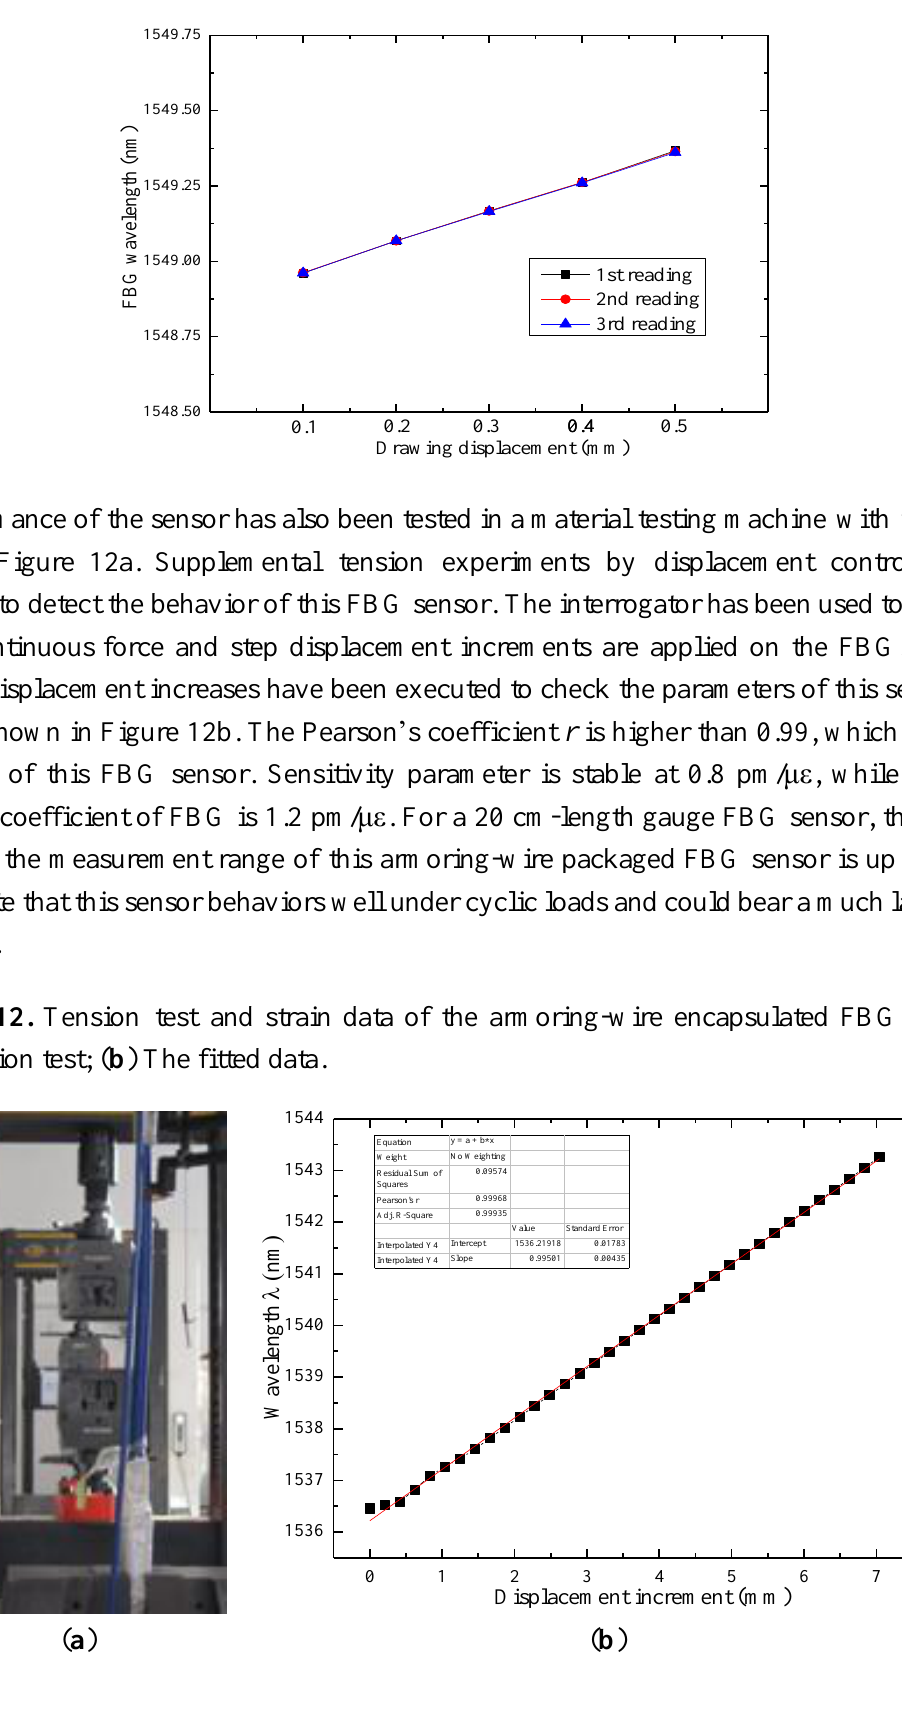
Figure 11. Tension test data of a FBG connected in series with a spring.